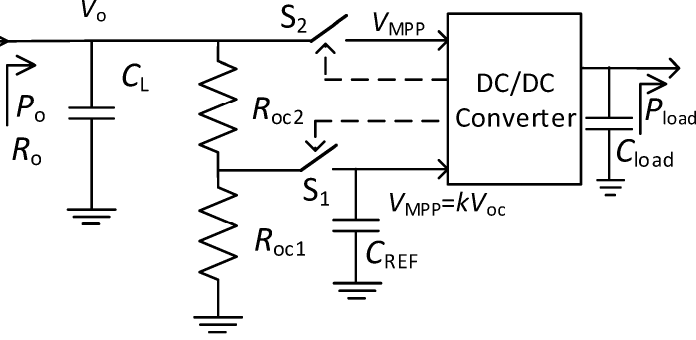
Figure 3. Block diagram of an implementation of the FOCV-MPPT